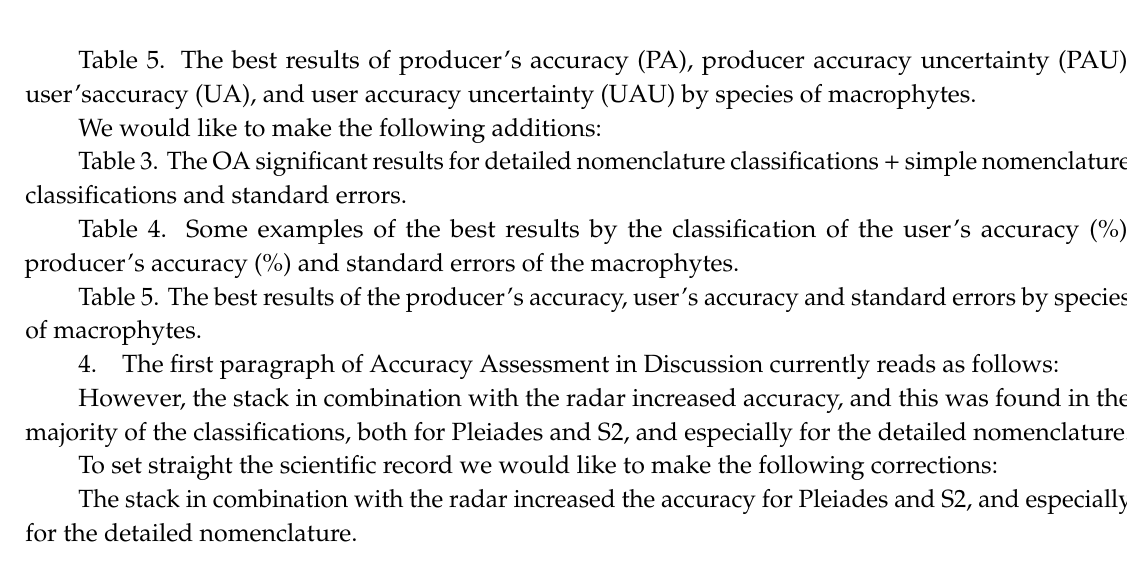
Table 5. The best results of producer’s accuracy (PA), producer accuracy uncertainty (PAU),